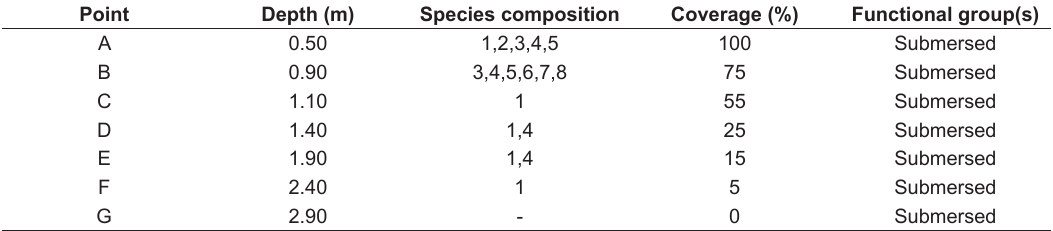
Table 1. Depth of water column and species composition of macrophytes along the sampling points (adapted from They et al.,